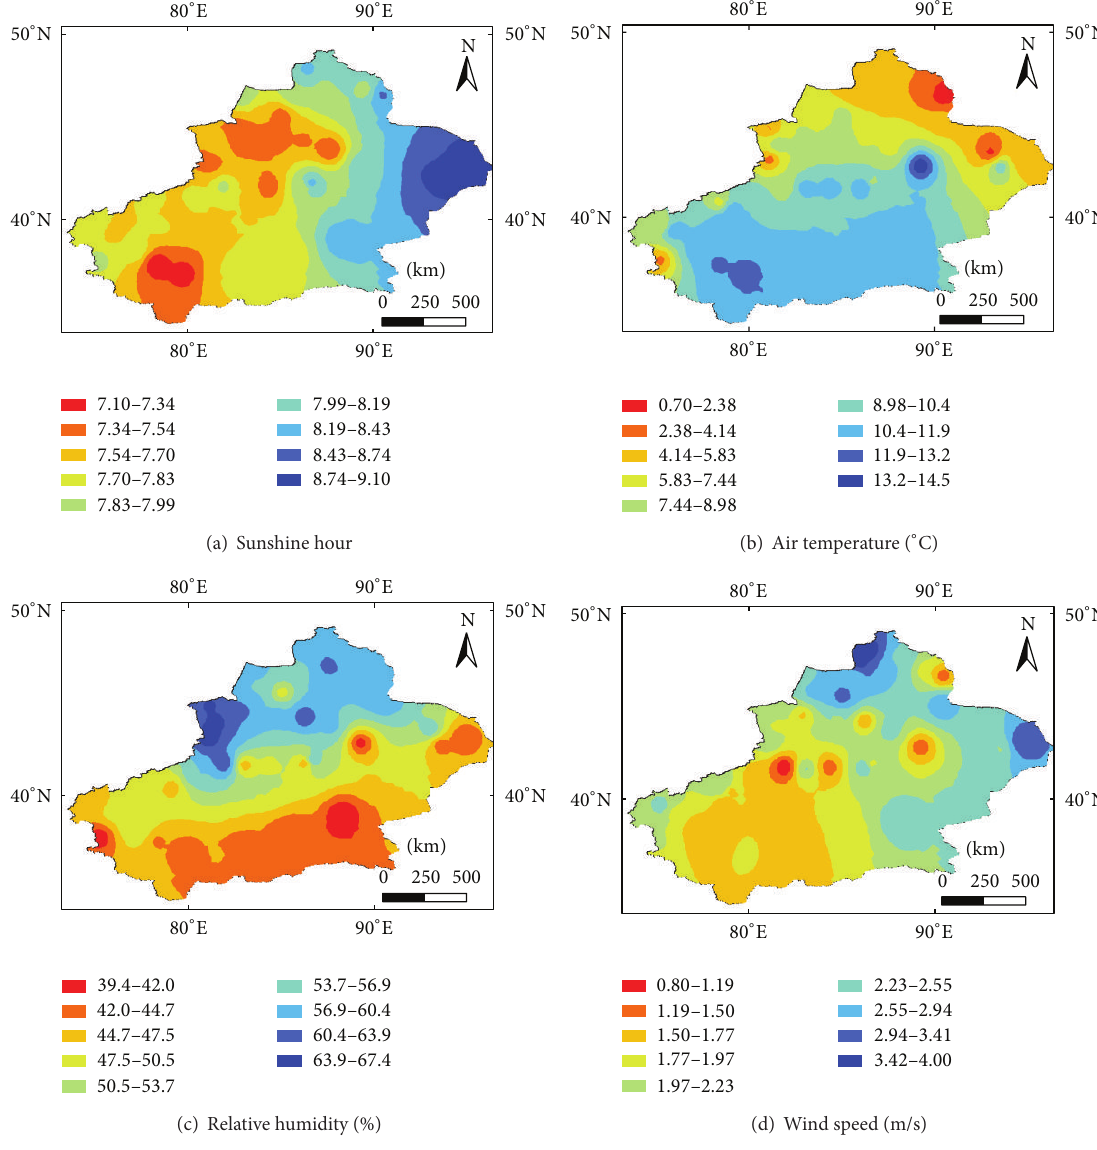
Figure 2: Spatial distributions of the multiyear mean climatic elements in the study